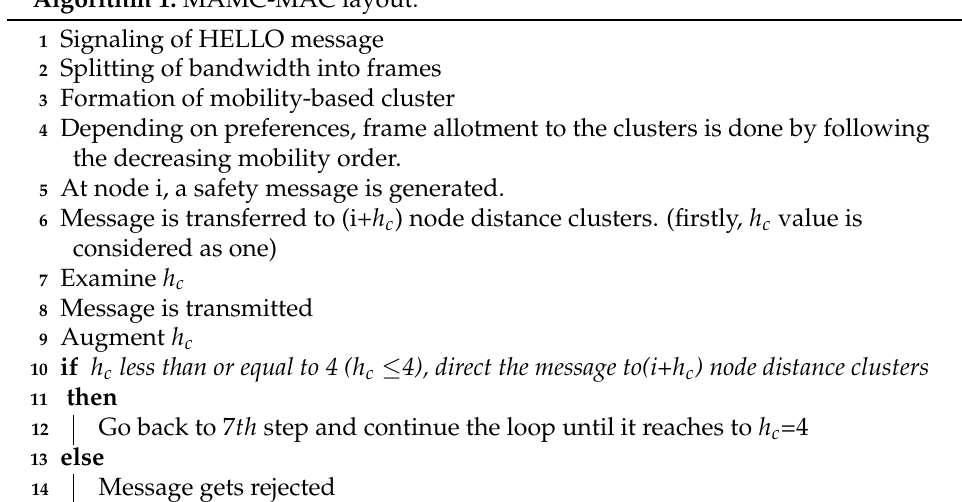
Algorithm 1: MAMC-MAC layout.